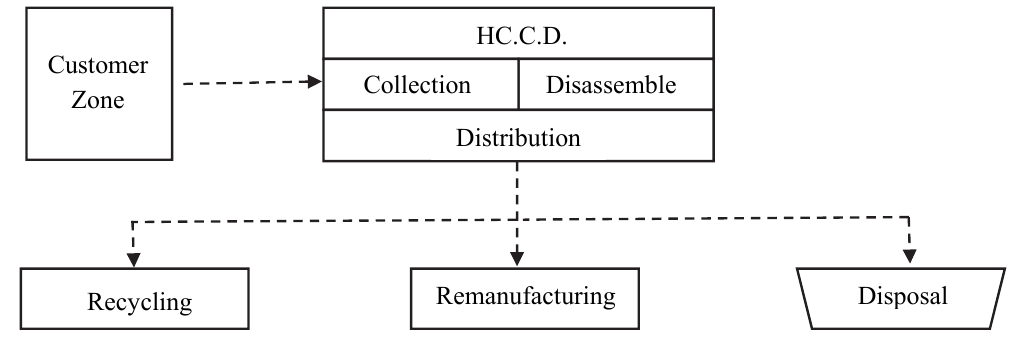
Fig. 1 . Proposed structure of closed-loop supply chain network